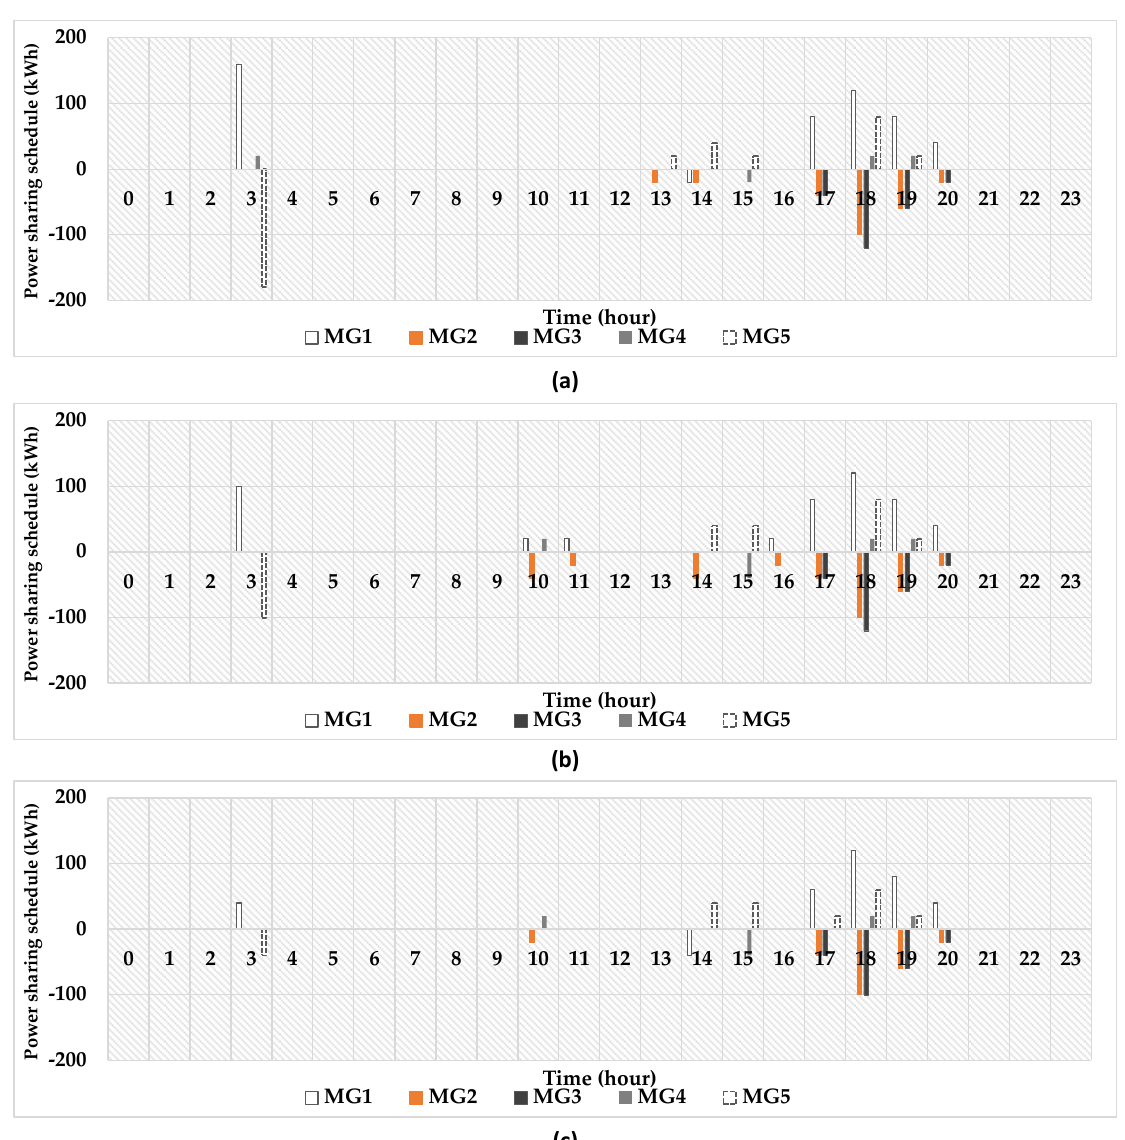
Figure 14. Power sharing schedule considering the loss cost: ( a ) l = 2%, ( b ) l = 5%, and ( c ) l = 15%.